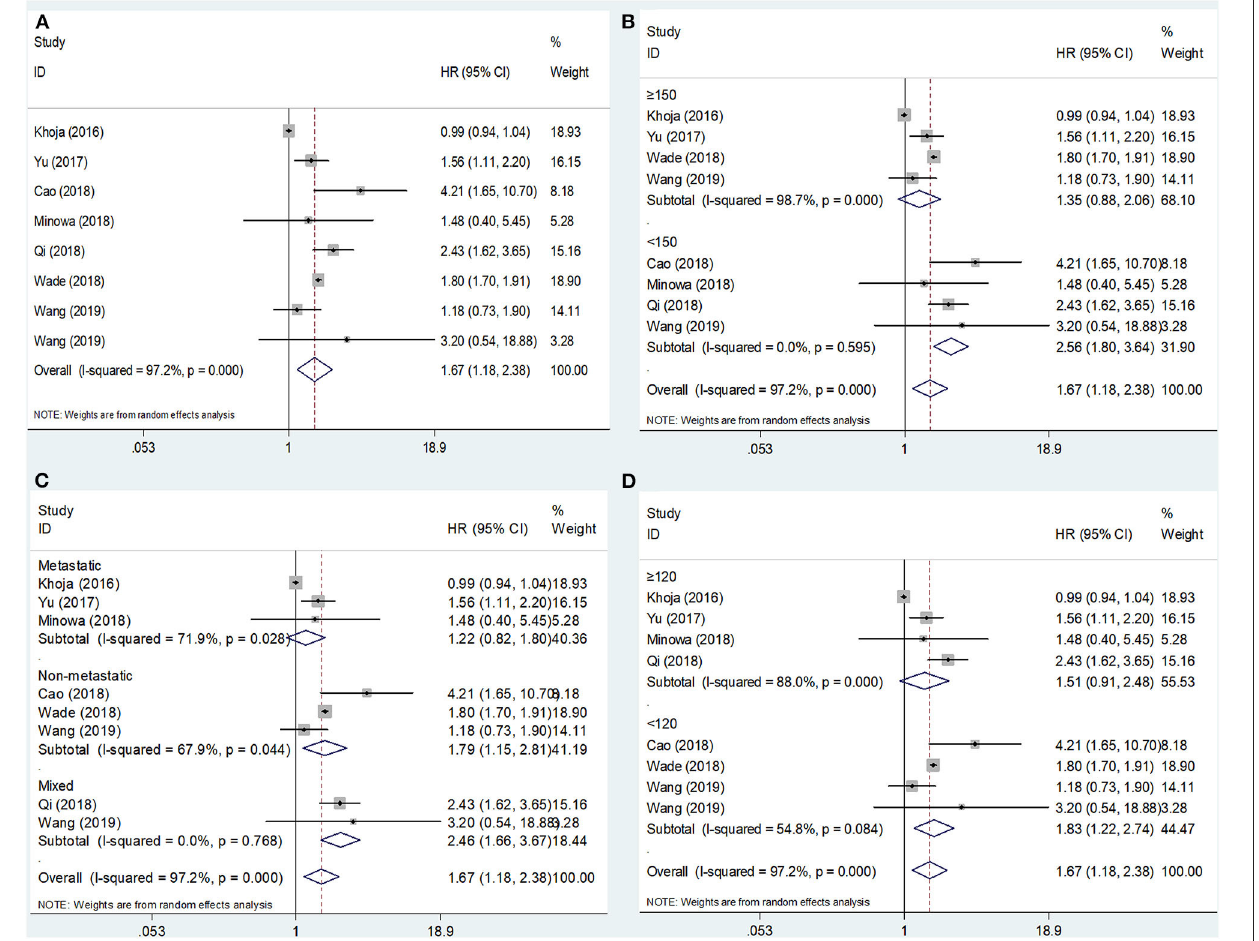
Frontiers in Oncology |